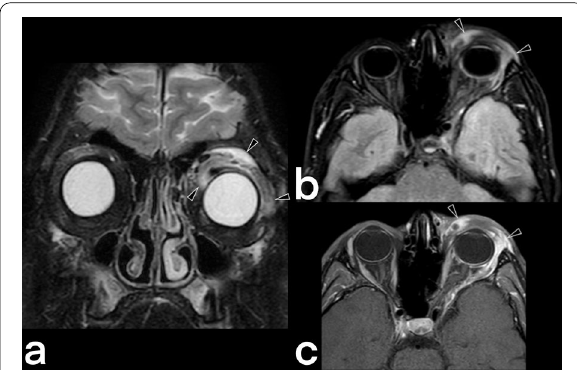
Fig. 13 A 19-year-old male patient. T2 weighted coronal ( a ), axial FLAIR ( b ), and T1 weighted post-contrast axial ( c ) images show periorbital involvement (arrowheads)